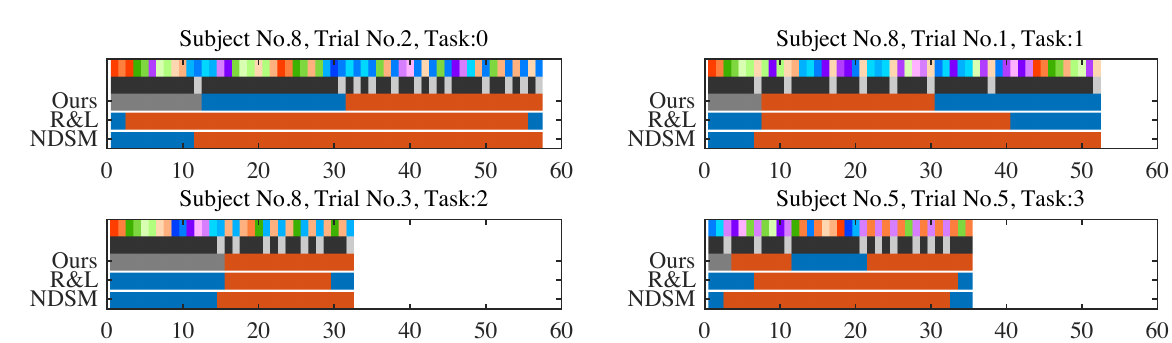
Figure 8 . Examples of estimated browsing state sequences. For each sequence, the color in the top row corresponds to the color of regions in Fig. 2. In the second row, the timings of the dwells on the selected item is shown by light gray highlights. From the third row to the bottom row, the blue and red intervals correspond to the exploration state and the evaluation state, respectively.